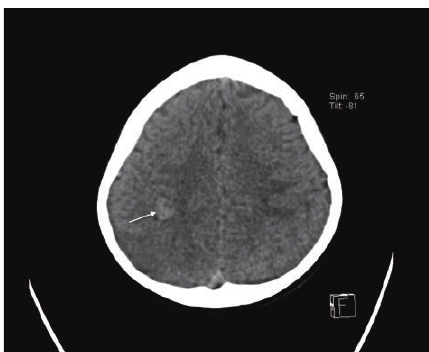
Figure 3: Sagittal T1-weighted MRI reveals low-attenuating throm- bus (arrows) within superior sagittal sinus.